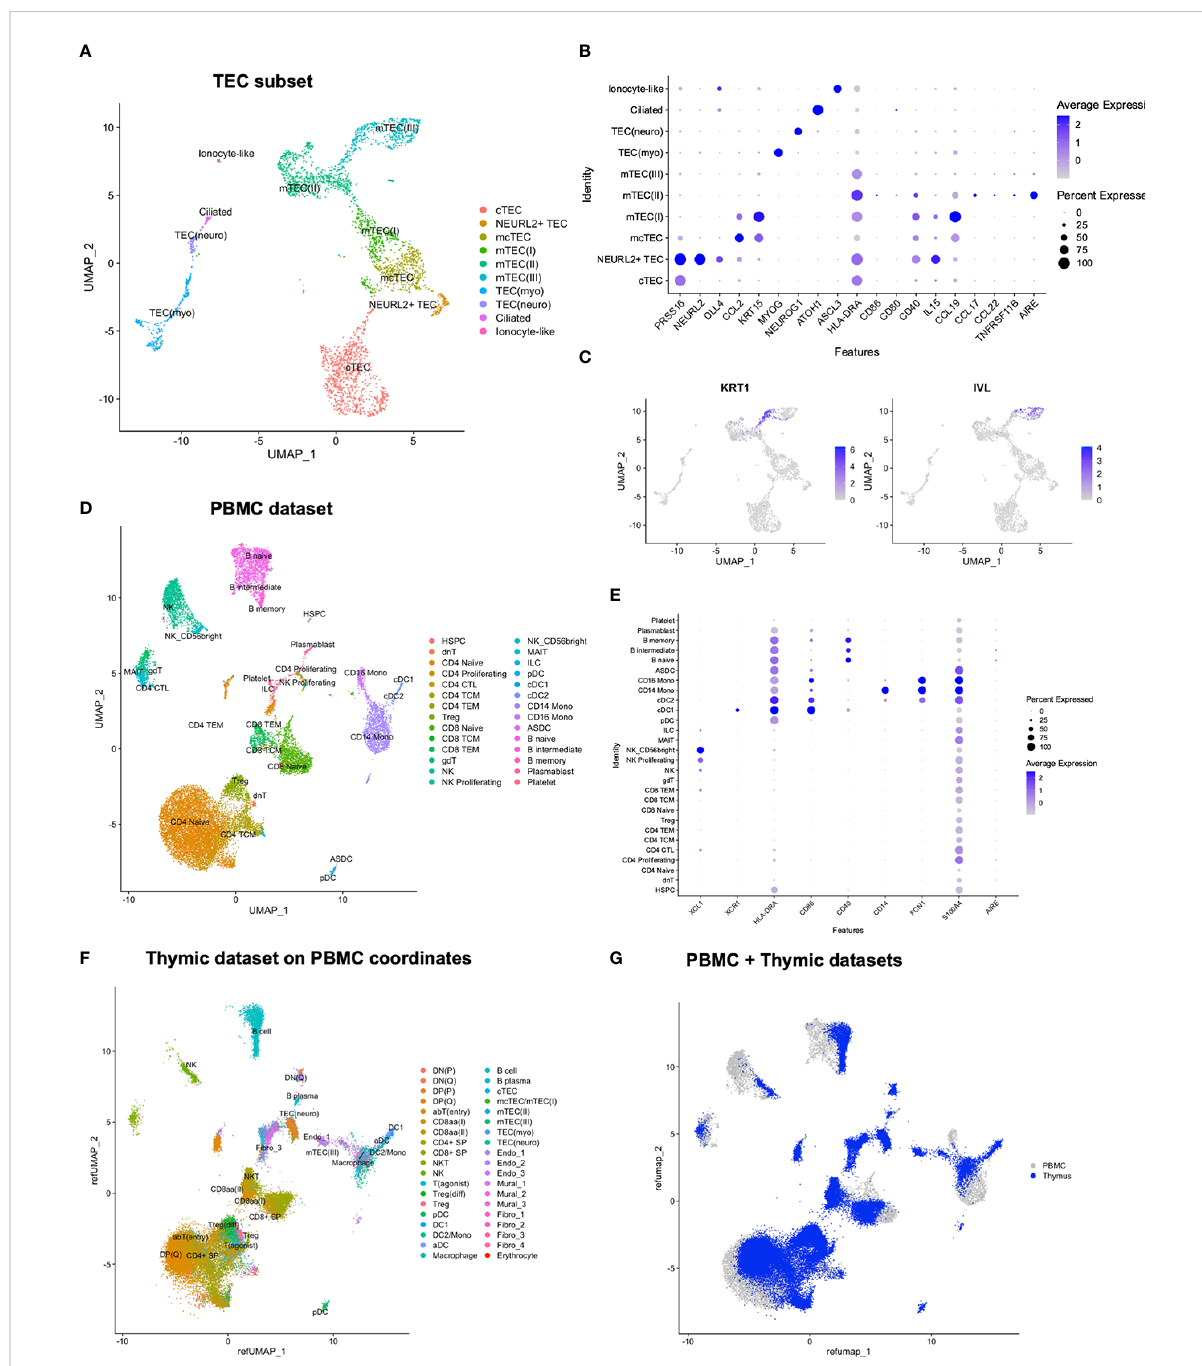
FIGURE 5 Reanalysis of TEC subset and comparison of thymic and peripheral cell populations. (A) UMAP of TEC subset. (B, C) Expression of selected genes in TEC subset. (D) UMAP of PBMCs with predicted annotations. (E) Expression of selected marker genes in PBMCs. (F) Thymic dataset mapped onto the UMAP coordinates of the PBMC dataset. (G) Merged UMAP of PBMC and thymic datasets after mapping of thymic dataset onto the PBMC UMAP